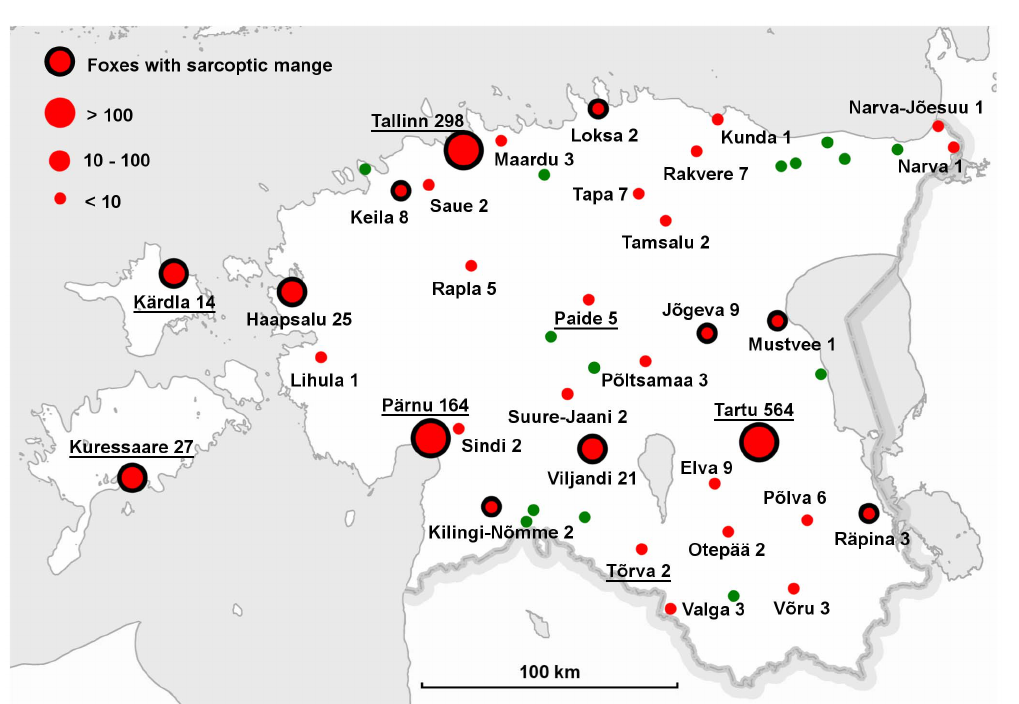
Fig. 1. Red foxes in urban areas in Estonia. Foxes were reported in 33 towns (red points) out of 47. The numbers on the map indicate the numbers of people reporting fox sightings. Black rings around red points indicates towns where foxes with symptoms of sarcoptic mange were reported. Green points indicate the 14 towns where urban foxes were not reported. Underlining indicates towns where fox dens were